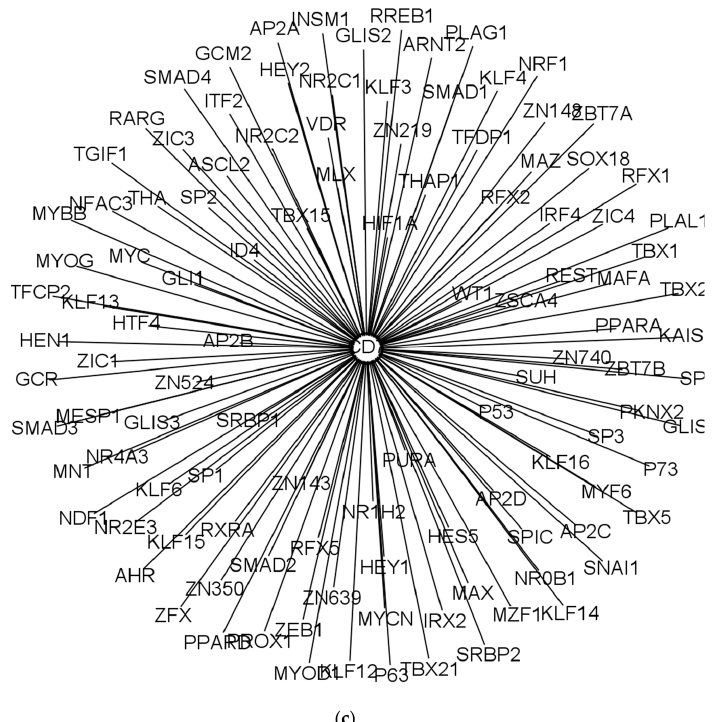
Figure 3. Deferential receptor regulatory subnetworks. In the network, nodes represent genes and transcription factors (TFs), while links represent gene regulatory relations. Arrows represent TFs regulating genes. The differential receptor regulatory network derived from the GRN of the PD hi CD8 T cells with the GRN of the: ( a ) CD8 naïve cells; ( b ) CD8 effector memory cells; and ( c ) CD8 central memory T cells.